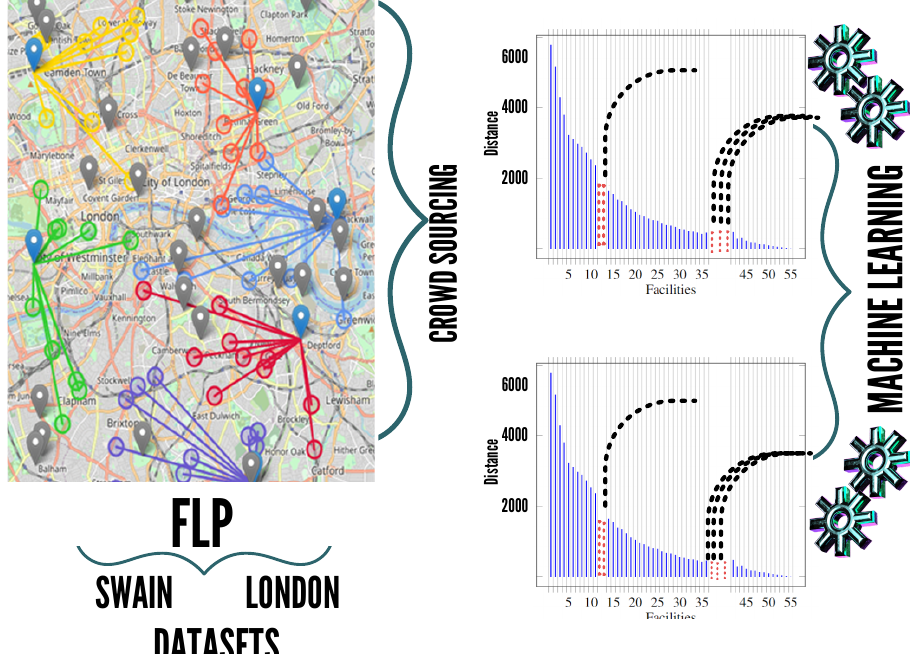
Figure 4. Experimental setup for solving the FLP and for complementing genetic